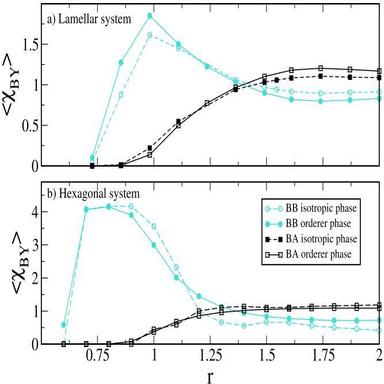
The behavior of the relative clustering parameter as a function of distance for the different particle pairs is shown. Dashed lines represent the behavior for isotropic phases and solid lines represent the behavior for ordered phases. The top figure corresponds to the lamellar system and the bottom figure corresponds to the hexagonal system.